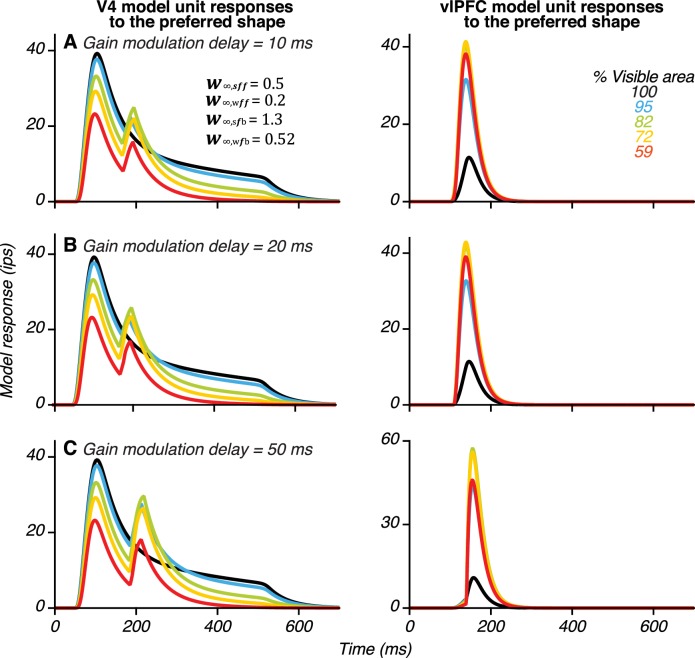
Effect of delaying the arrival of gain modulation signals to vlPFC in the model.To consider the possibility that gain modulation signals carrying information about occlusion level (f-PFC, see Figure 9) may be communicated via feedforward signals from IT cortex to vlPFC, we tested the effect of delays of 10 ms (A), 20 ms (B) and 50 ms (C) on the arrival of gain modulation signals relative to the arrival of feedforward shape-selective signals from V4. By increasing this delay, the peak time of vlPFC responses and the second peak in V4 were slightly delayed, but in all three cases, our simulations produced robust second peak in the V4 unit.